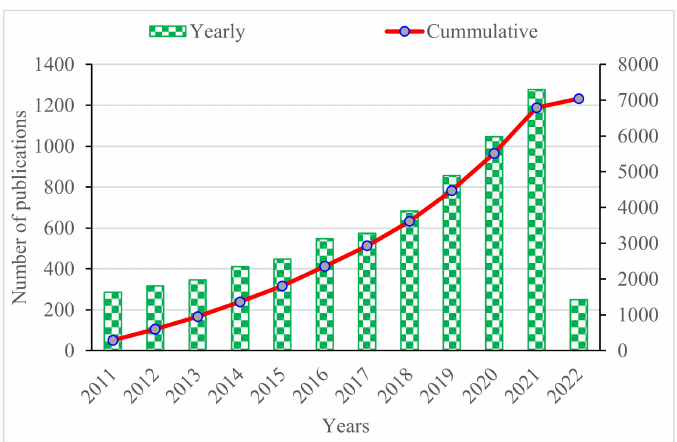
Figure 4. Annually published